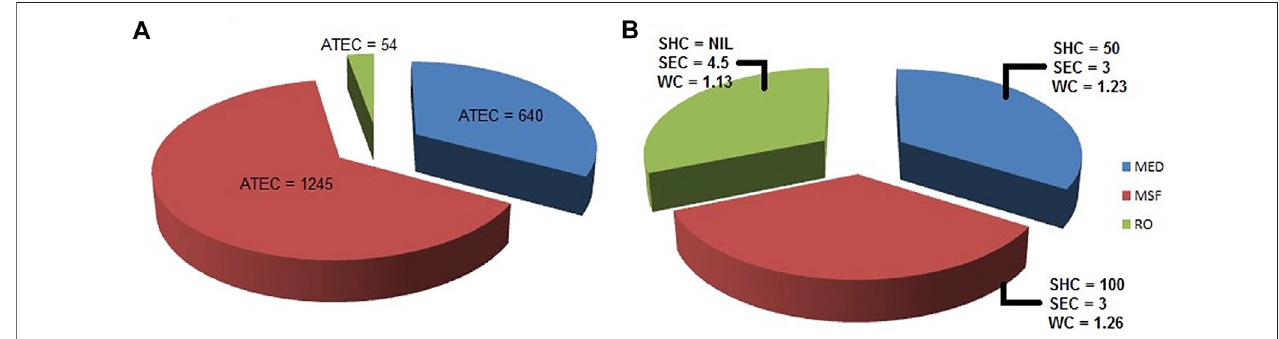
FIGURE7| ComparisonofMED,MSFandRO. (A) Averagetotalenergyconsumption(ATEC)expressedinMW (B) Speci fi cheatconsumption(SHC)expressedin kW